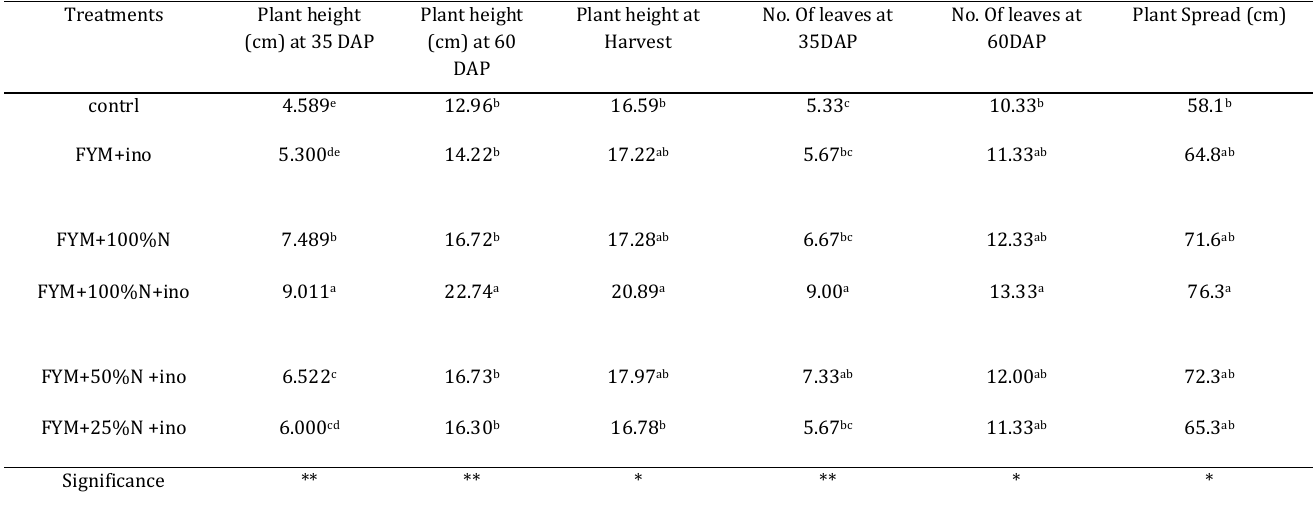
Table 2: Effect of Azotobacter on plant height, leaf no., plant spread, leaf area and yield of cauliflower in Lamjung